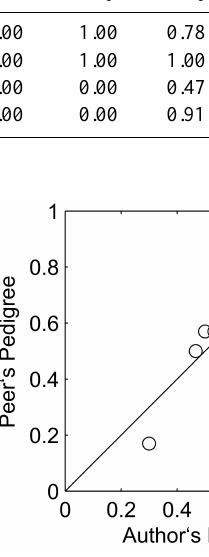
Table 2. Kappa statistics for the individual quality dimensions ( N = 10) and pooled over all quality dimensions ( N = 100). Access- Inter- Ease of Concise Sour- Path- Recept./ Accu- Objec- Repu- All ibility pret. underst. repres. ce way Cons. racy tivity tation QD